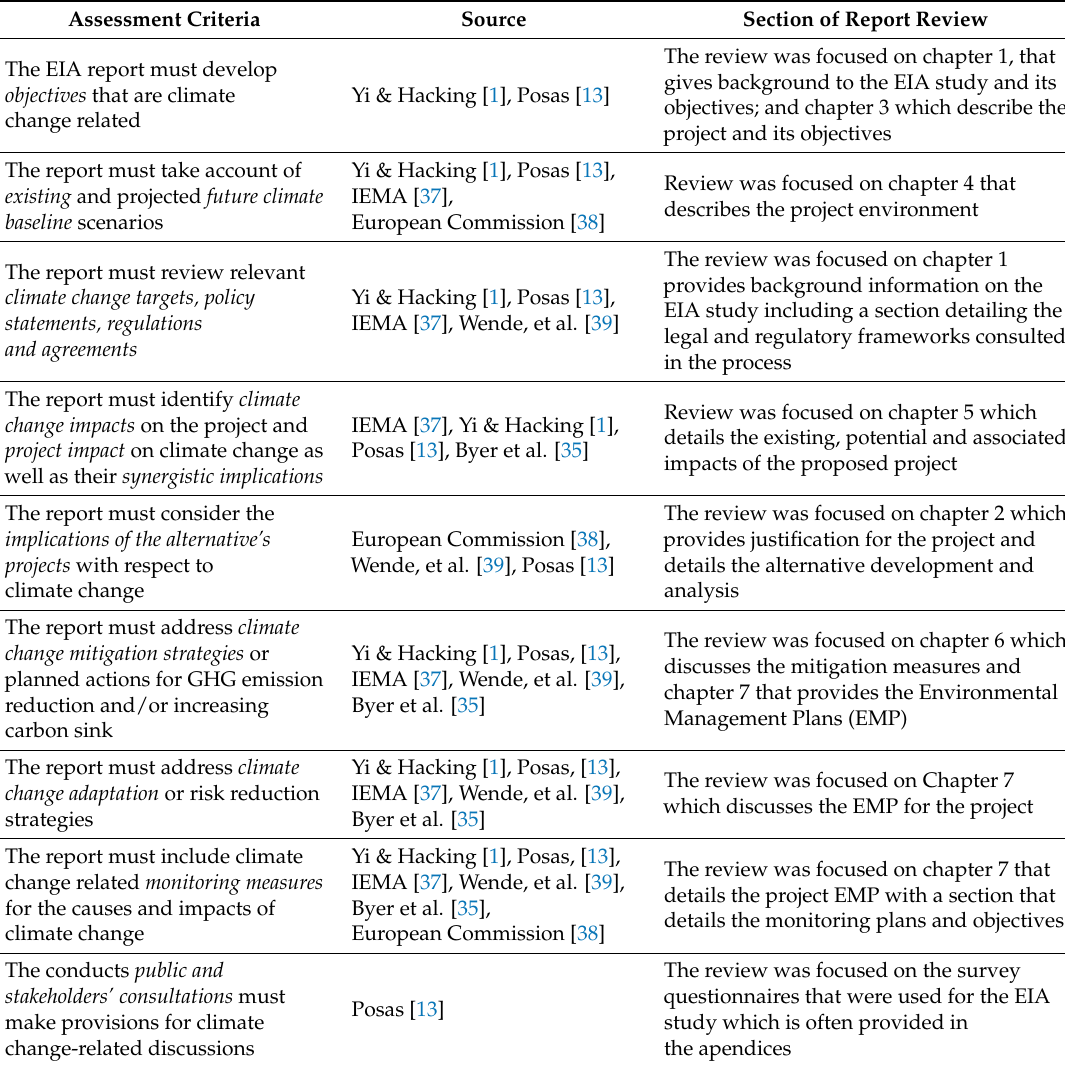
Table 4. Criteria framework for climate change